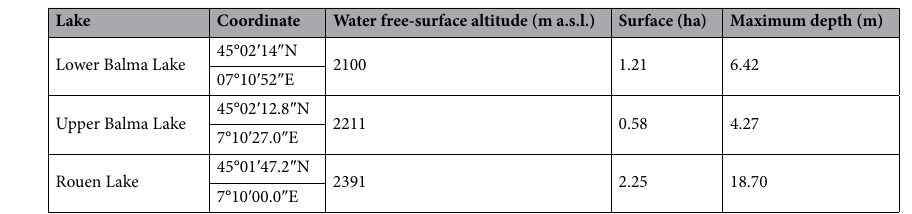
Table 4. Geographical coordinates, water free-surface altitude, surface, maximum depth of the